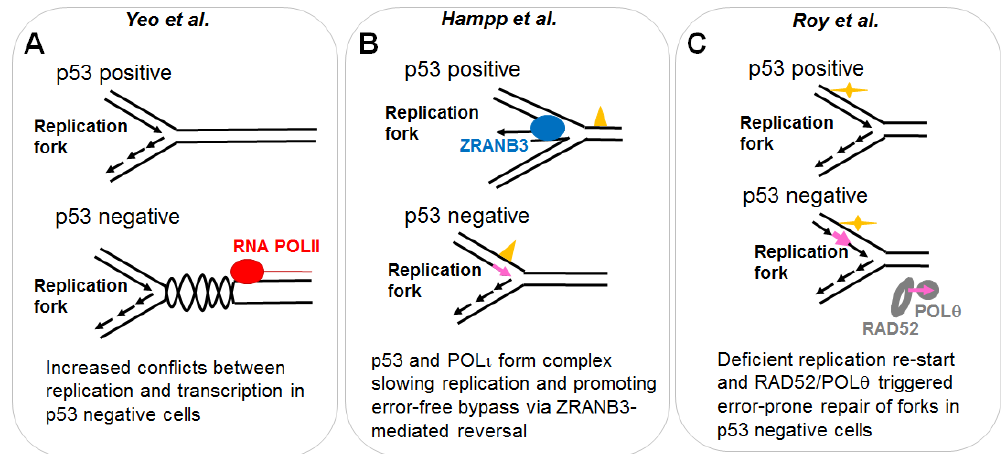
Figure 2. A potential direct role of p53 in DNA replication. The role of p53 in DNA replication was evaluated using the DNA spreading technology. ( A ) p53 prevents the generation and/or the stabilization of topological conflicts between transcription and DNA replication. The mechanism by which p53 prevents such conflicts is unknown. p53 deficient cells, which accumulate such type of conflicts on replicating DNA, rely heavily on Topo2. Inhibitors of such enzyme, selectively kill p53 deficient cells. ( B ) p53 positive cells are more prone to the activation of an error-free post-replication repair mechanism resulting in replication associated recombination, which likely depends on ZRANB3 mediated fork reversal [39]. Such an effect correlates with a reduction in nascent DNA elongation speed in p53 expressing cells and depends on the specialized DNA POL ι , which interacts with p53. An H115N mutant of p53, impaired in its exonuclease activity, is incapable of interacting with POL ι , promoting replication-associated recombination and restraining nascent DNA elongation. Yellow triangle: DNA damage caused by MMC. Pink arrow: Mutagenic DNA replication events, possibly dependent on specialized POLs. ( C ) p53 promotes DNA replication continuity and prevents the recruitment of RAD52 and POLθ. According to the literature RAD52 and POLθ should mediate error-prone repair of collapsed forks [49]. The use of H115N and S47P variants of p53 demonstrated that the control of DNA replication restart by p53 correlates with its tumor suppressor function independently of transcriptional activation. Yellow mark: HU treatment. Pink arrow: Mutagenic replication by POLθ and RAD52.